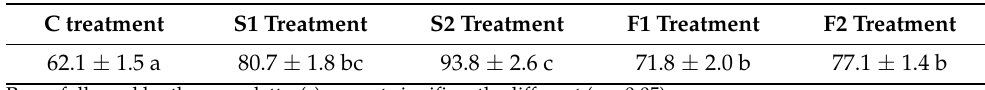
Table 6. Effect of biostimulant obtained from slaughterhouse sludge on lycopene content (mg kg − 1 fresh wt.) in tomatoes